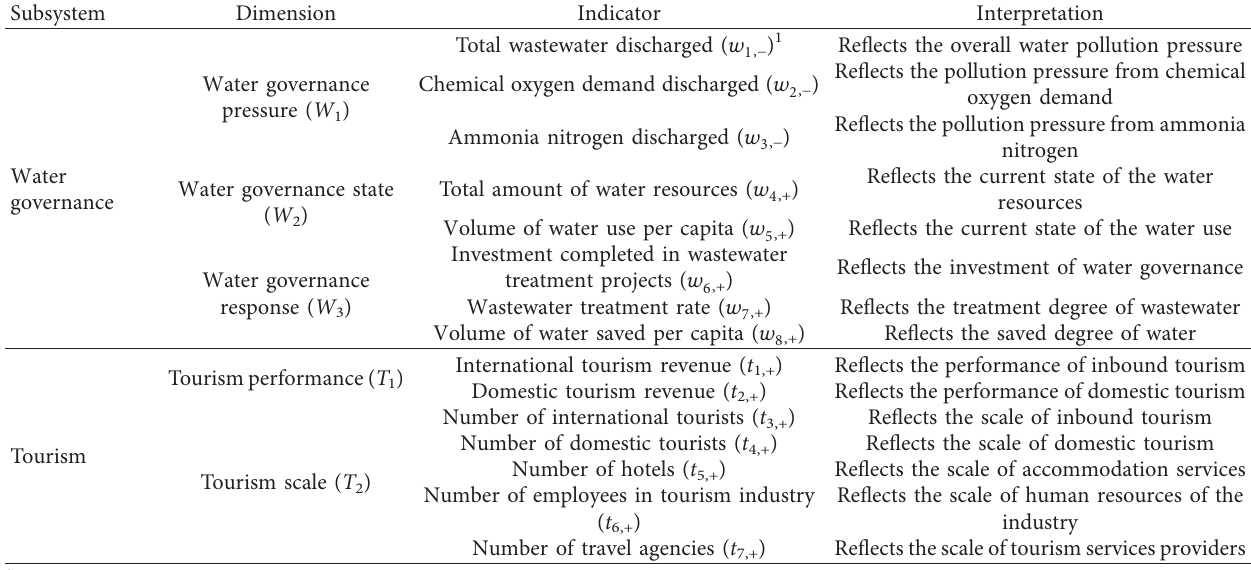
Table 1: Water governance-tourism evaluation